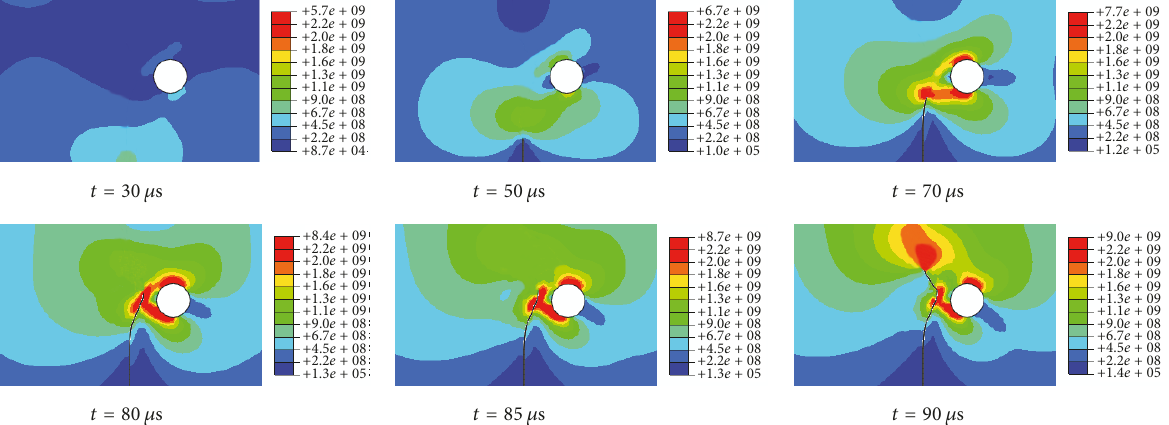
Figure 9: Change of von Mises stress contour plots with time 𝑡 .